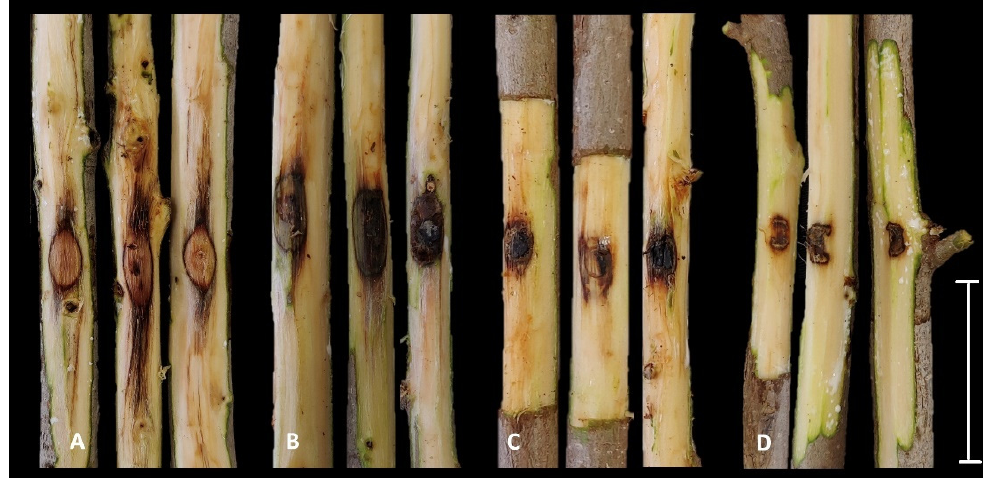
Figure 4. Results of pathogenicity test after two weeks. ( A ) Neofusicoccum mediterraneum . ( B ) N. parvum . ( C ) Botryosphaeria dothidea . ( D ) Control. Scale bar = 10 cm.